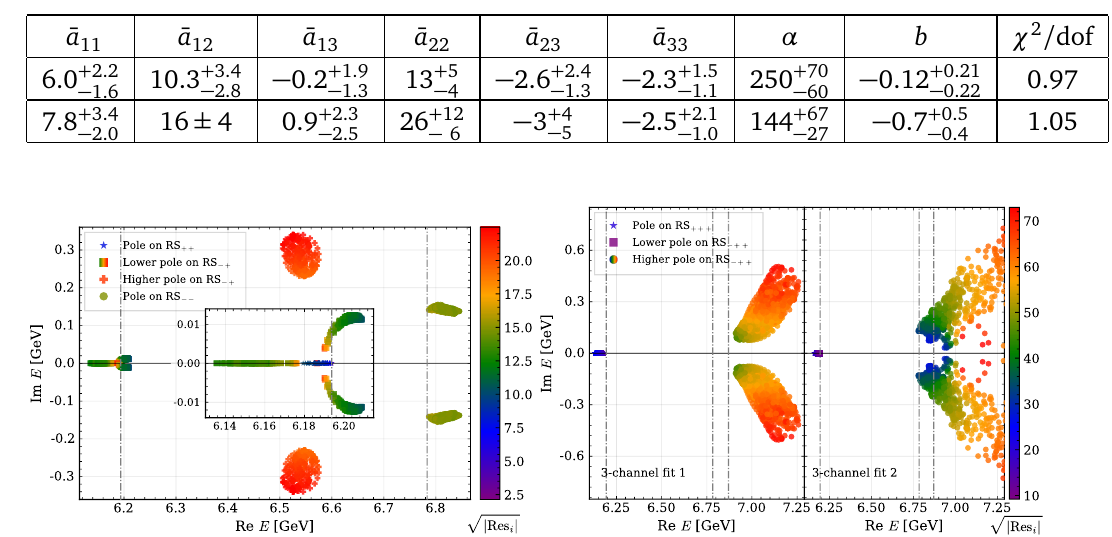
Table 2: Fitted parameters of the 3-channel model ( [ ¯ a